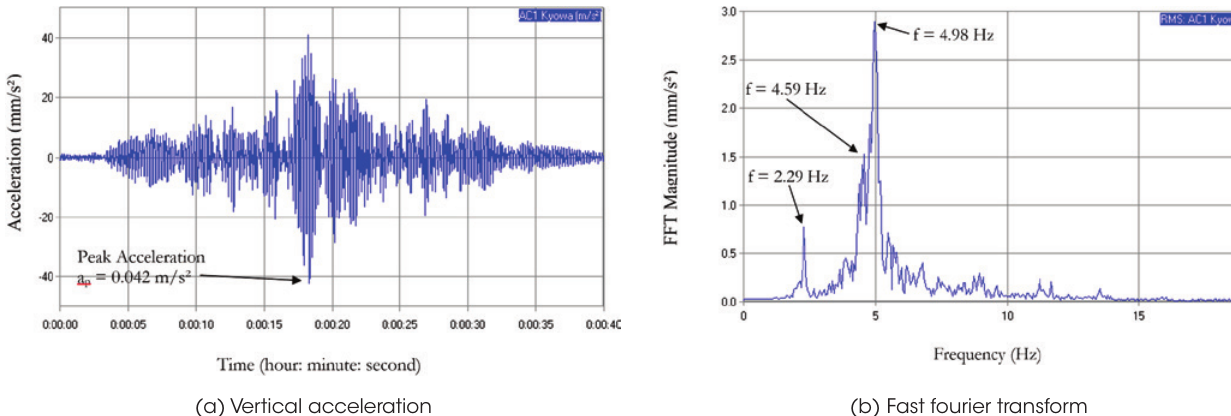
(a) Vertical acceleration